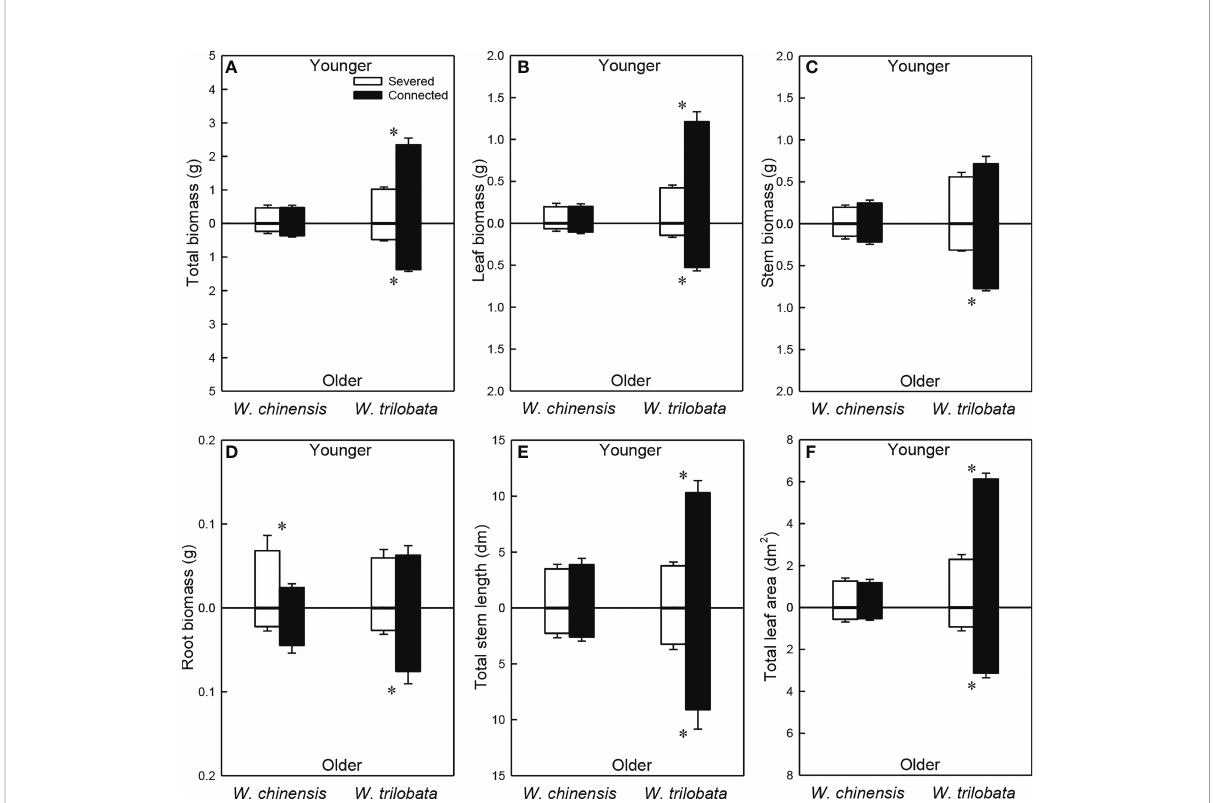
FIGURE 5 Total biomass (A) , leaf biomass (B) , stem biomass (C) , root biomass (D) , total stem length (E) and total leaf area (F) of the younger ramet (above the x-axis) and the older ramet (below the x-axis) of the invasive plant Wedelia trilobata and the native plant W. chinensis . Values are means ± SE. Symbols (* P < 0.05) indicate the signi fi cant differences between the severed ramets and connected ramets within a